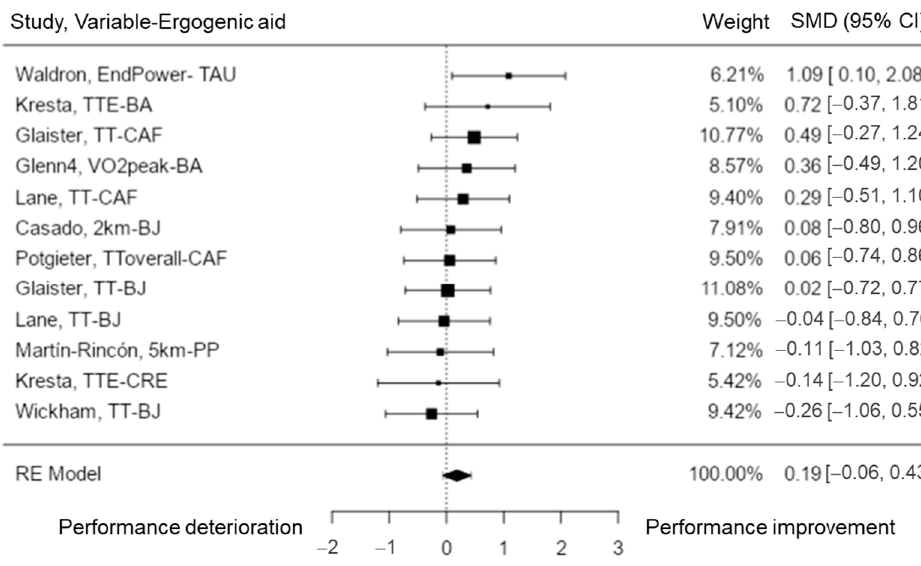
Figure 5. Sprint performance forest plot. 20m = 20 m sprint; MST = mean sprint time; T-Test = T Agility Test.